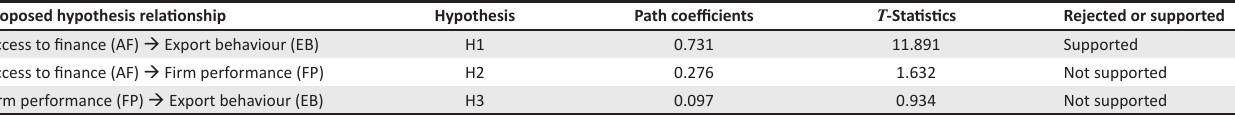
TABLE 4: Results of structural equation model